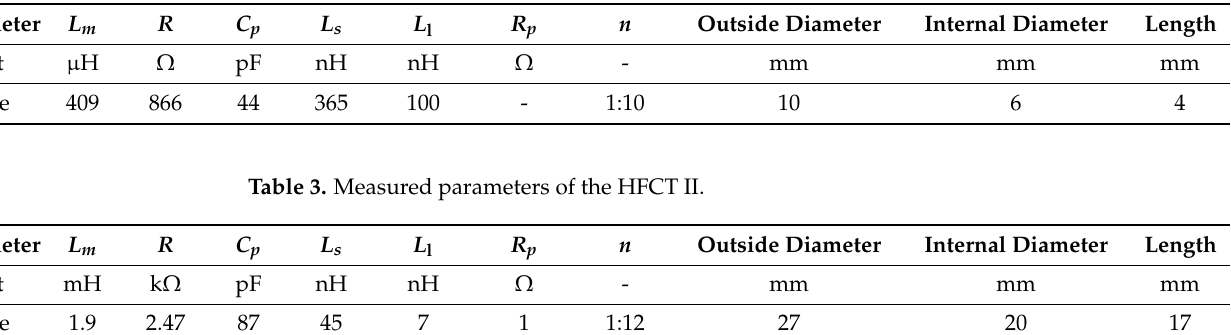
Table 2. Measured parameters of the HFCT I.